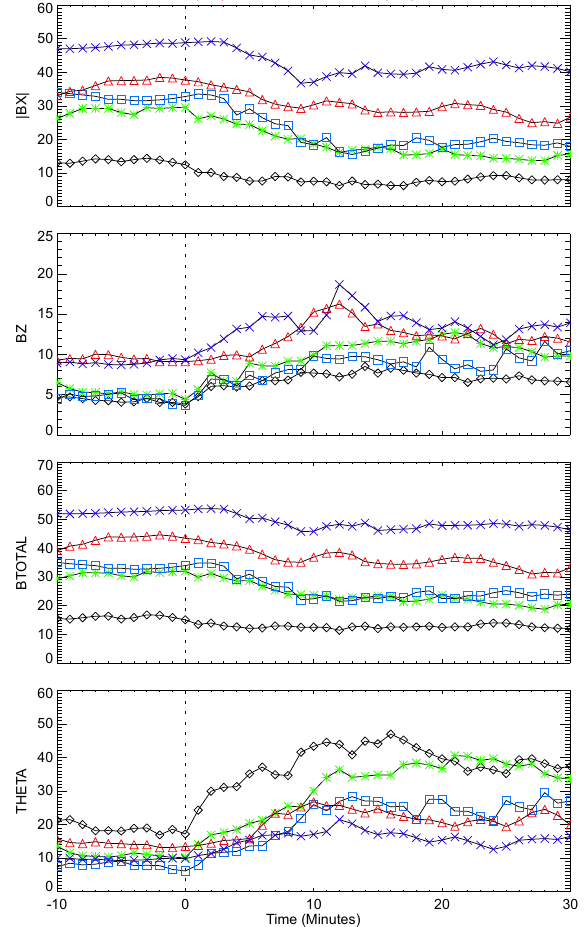
Fig. 11. Results of the superposed epoch study for the isolated events showing the dependence of dipolarization properties on the distance to the neutral sheet. We used 1min averages of the mag- netic field in the regions − 18 <X< − 8 R E , 0 < | Y | < 12 R E . The ab- solute value of B x is plotted in Fig. 10 to prevent B x from averaging to